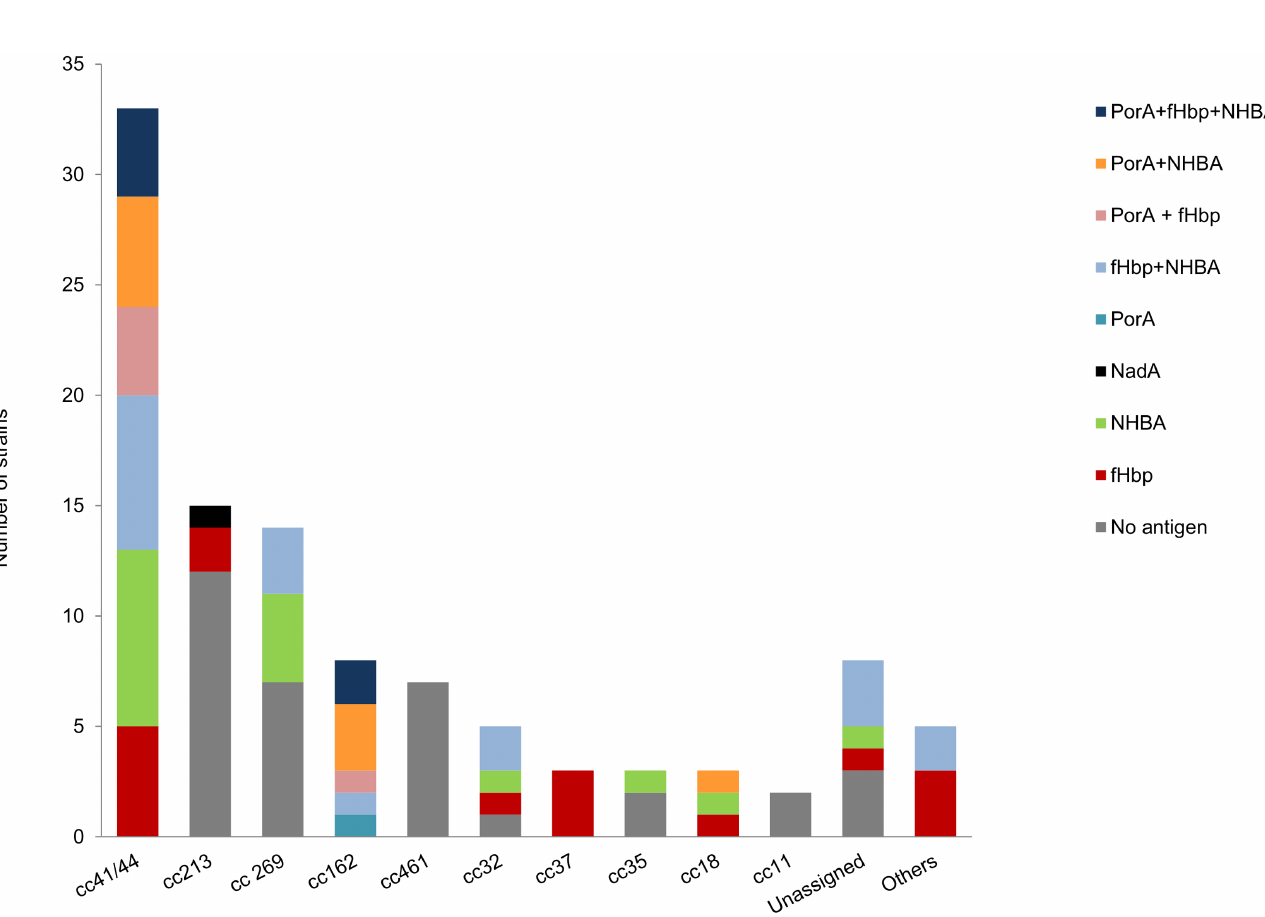
Fig 2. Distribution of the vaccine antigens within each clonal